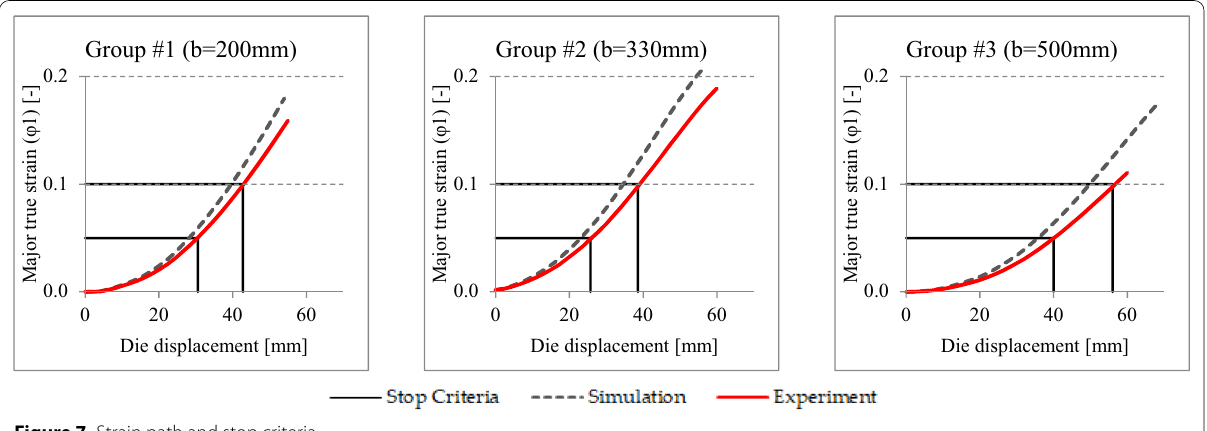
Figure 7 Strain path and stop